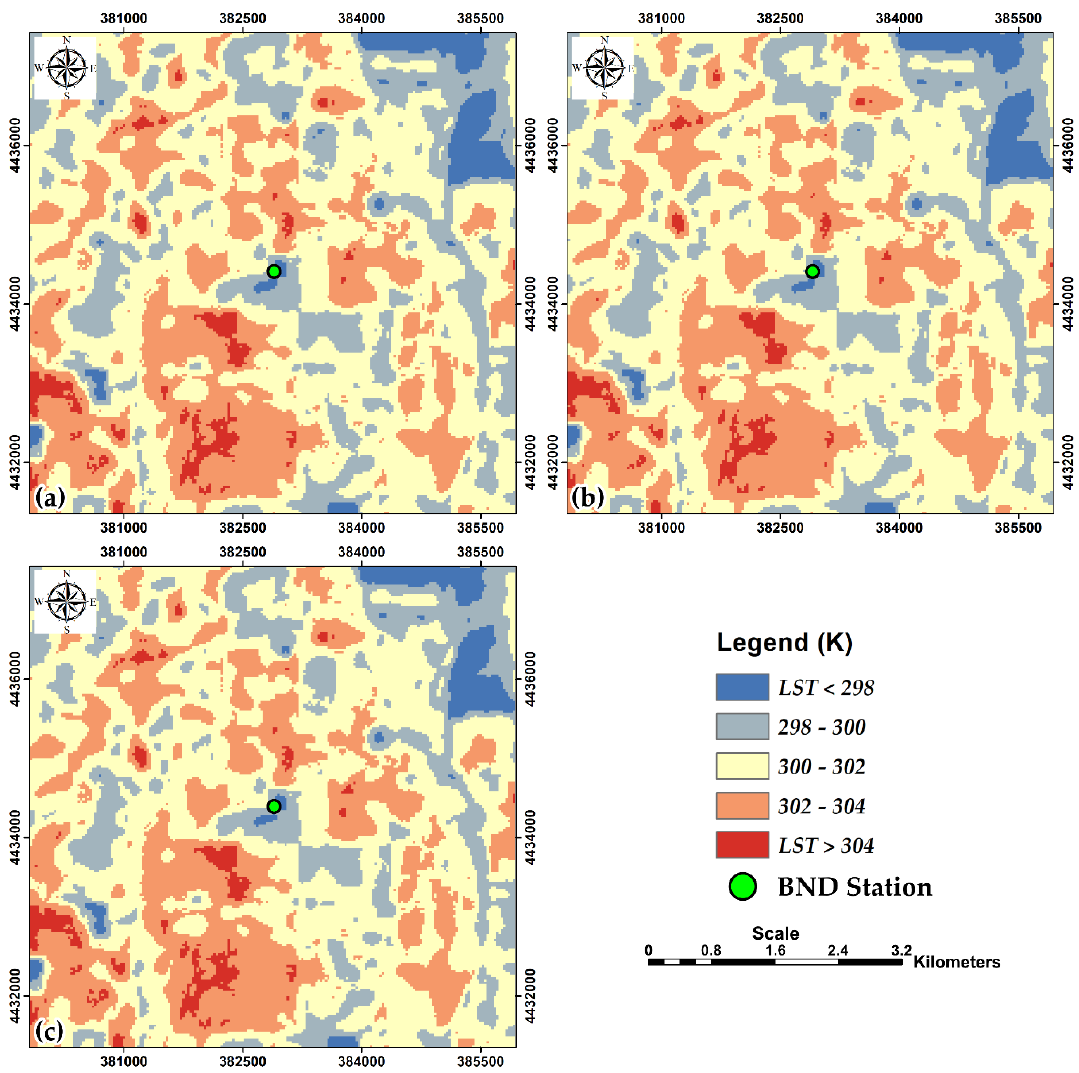
Figure 2. Landsat 8 LST image (27 April 2018) over the 6 × 6 km 2 rural area covering the BND station, for the three methods used in this analysis: ( a ) MWA-based LST, ( b ) RTE-based LST, ( c ) SCA-based LST. The coordinate system, projection and zone information of maps are the World Geodetic System 1984 (WGS84), Universal Transverse Mercator (UTM) Projection, and Zone 16 N, respectively. To analyze the spatio-temporal and seasonal LST variations among the LST retrieval methods, the 45 Landsat images were categorized into three seasons: spring (18 images), summer (13), and autumn (14), and Root Mean Square (RMS) di ff erences were calculated for each image. Winter images were not available due to cloudy conditions (see Table A1). This is not an accuracy test as the one performed by the SURFRAD LST ground measurements, but it is an image-based analysis to highlight the di ff erences among the three retrieval methods. Therefore, the RMS di ff erence is used instead of the RMSE. In the 6 × 6 km 2 selected areas, the minimum LST values from satellite data for spring, summer, and autumn are 280.29 K, 281.70 K, and 284.67 K, respectively; the maximum are 321.88 K, 330.67 K, and 317.95 K, respectively. Figure 3 shows the box-plot graph presenting the seasonal RMS di ff erences between the LST retrieval methods. The box-plot is used to display distributional characteristics of data [106]. The box-plot information, reported in Figure 3 by numbers, is the minimum (1) (the lowest data point excluding any outliers), first quartile (2), median (3), third quartile (4) and maximum (5) (the largest data point excluding any outliers). The cross “x” in the boxes refers to the mean value of the data set, and the points outside the minimum, and maximum values are assumed as